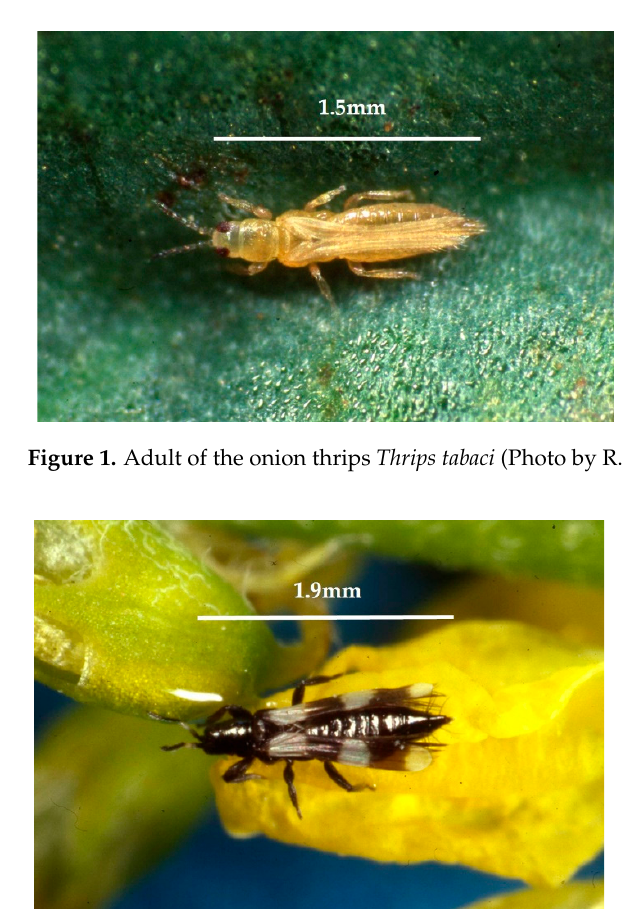
efficacy of these predators is not considered decisive [6]. Among the T. tabaci predators, Aeolothrips intermedius Bagnall, 1934 (Thysanoptera: Aeolothripidae), is a cosmopolitan species [17,18], also known as “banded thrips” (Figure 2), even if all the congeneric species present the same characteristic of black and white banded wings. Both adults and larvae are floricolous (mainly found in Leguminosae, Rosaceae, and Poaceae; Table 1) and while adults feed mainly on flowers and pollen by their stem-sucking-rasping mouthparts, A. intermedius larvae prey on more than 44 species of Thysanoptera [19].